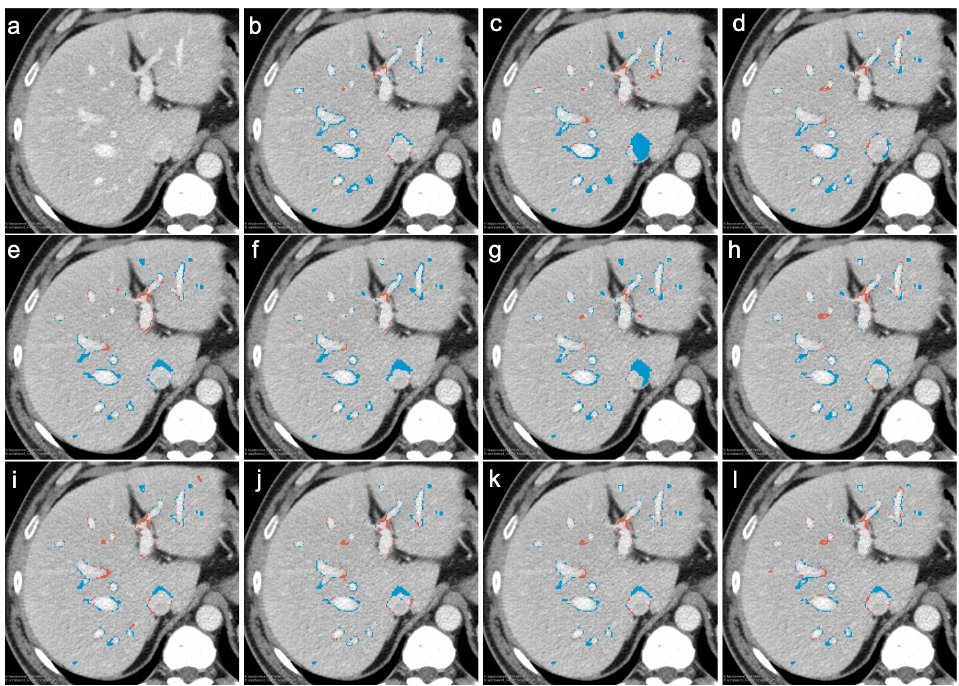
Figure 13. A slice in the CT images from test data followed by examples of oversegmentation (shown in red) and undersegmentation (shown in blue) from all image enchanchements tested. ( a ) Original image, ( b ) Unenhanced, ( c ) Frangi, ( d ) Hessian, ( e ) Meijering, ( f ) Sato, ( g ) FrangiGC, ( h ) HessianGC, ( i ) MeijeringGC, ( j ) SatoGC, ( k ) SegAdded, ( l ) FilterAdded.